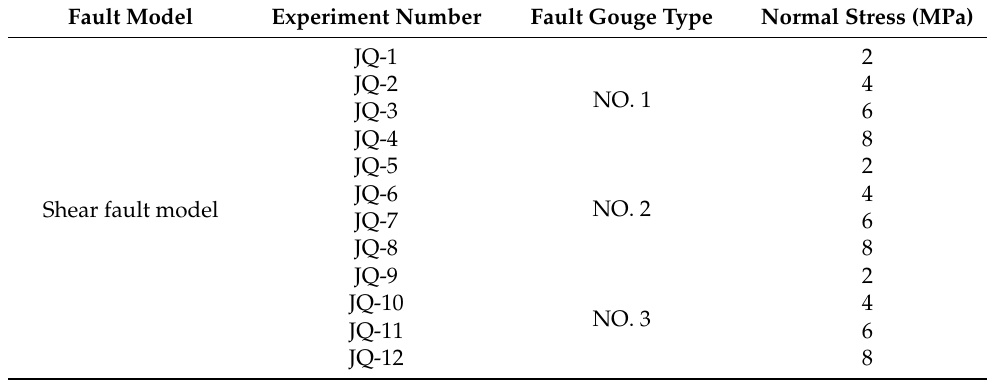
Table 2. Experimental design.